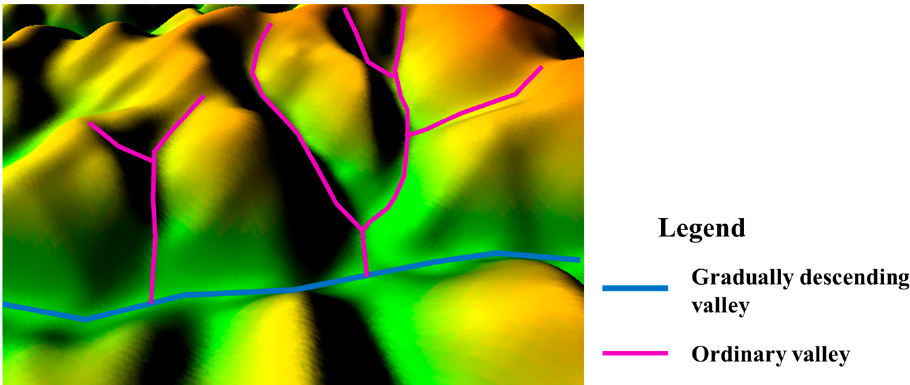
Figure 2. An example of a gradually descending valley and ordinary valleys using 3-dimentional modeling.